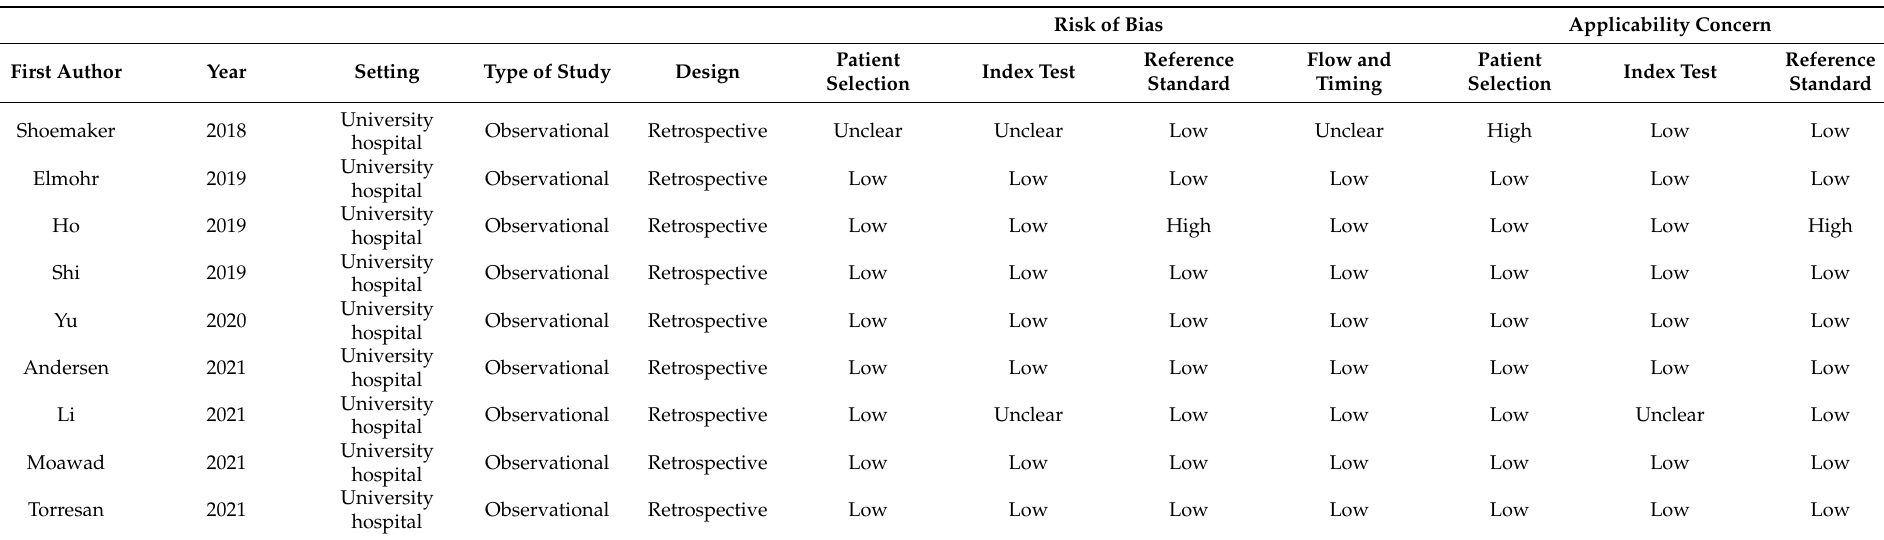
Table 2. Quality Assessment of Diagnostic Accuracy Studies (QUADAS) version 2 evaluation of the papers selected for the systematic